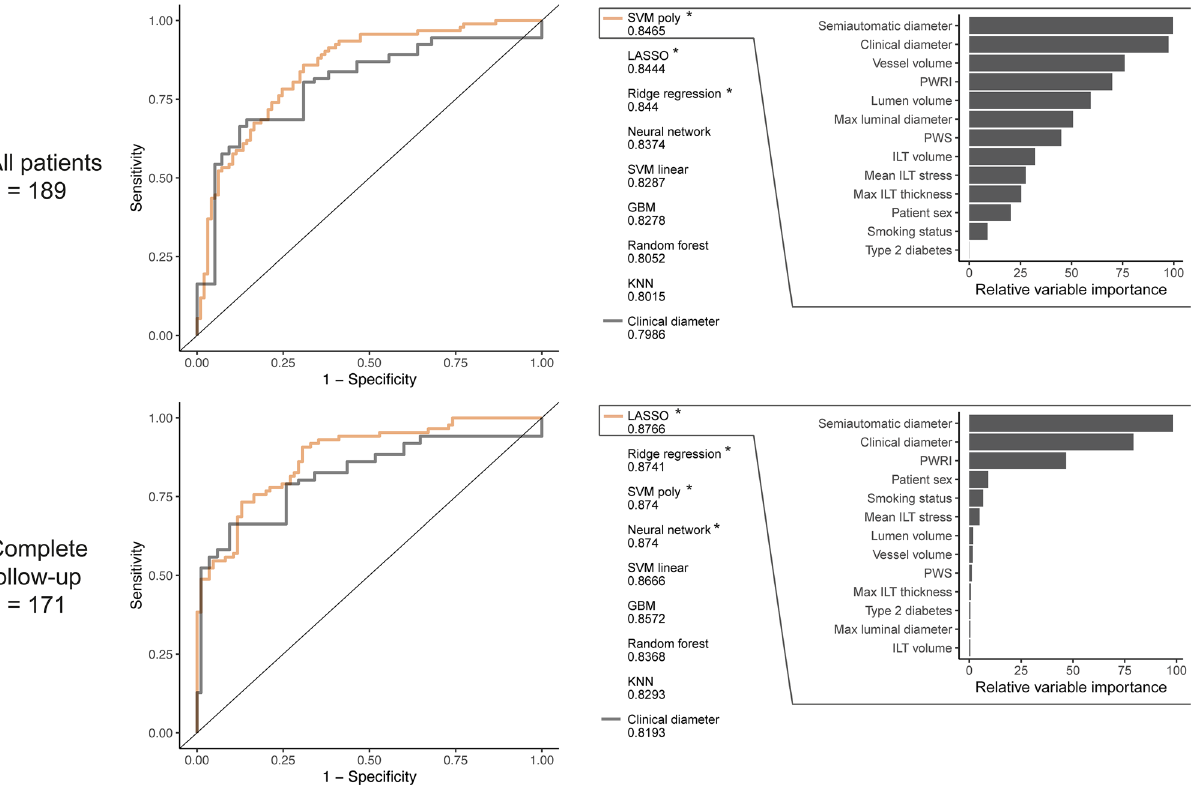
Figure 2. Prediction of reaching surgical threshold within four years. Predictions by different machine learning algorithms for all patients (upper row) and only those with complete follow-up (bottom row). Logistic regression of clinical diameter and patient sex served as reference. Variable importance is shown for the best model. The area under curve (AUC) is presented below each variable. Stars mark AUCs significantly larger than that of the clinical diameter reference. Abbreviations ; GBM: gradient boosting machines, ILT: intraluminal thrombus, KNN: k-nearest neighbors, LASSO: least absolute shrinkage and selection operator, PWRI: peak wall rupture index, PWS: peak wall stress, SVM: support vector machine with linear or polynomial kernel. Notations: *: p <